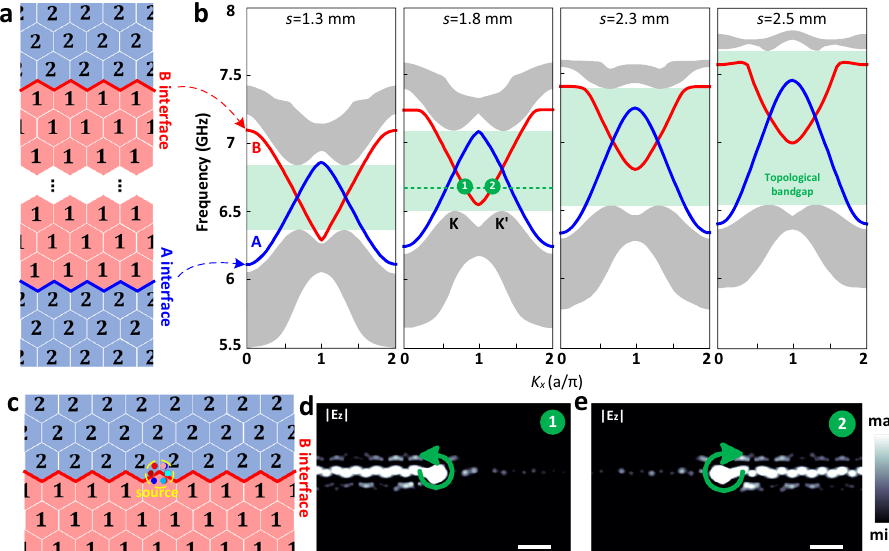
Fig. 2 Domain-wall interface modes of RPTI and the unidirectional topological propagation feature. a Topological domain-wall interface. The interfaces A and B separate two crystal domains, which are fi lled with digital unit-1 (symbol “ 1 ” ) and unit-2 (symbol “ 2 ” ), respectively. b Projected band diagrams. The topological bandgap increases with the length s of outer arm. c Straight waveguide with a B-type nontrivial interface, where a chiral source is employed. d , e Simulated unidirectional propagations with the RCP ( d ) and LCP ( e ) excitations. White scale bar, 30 mm.